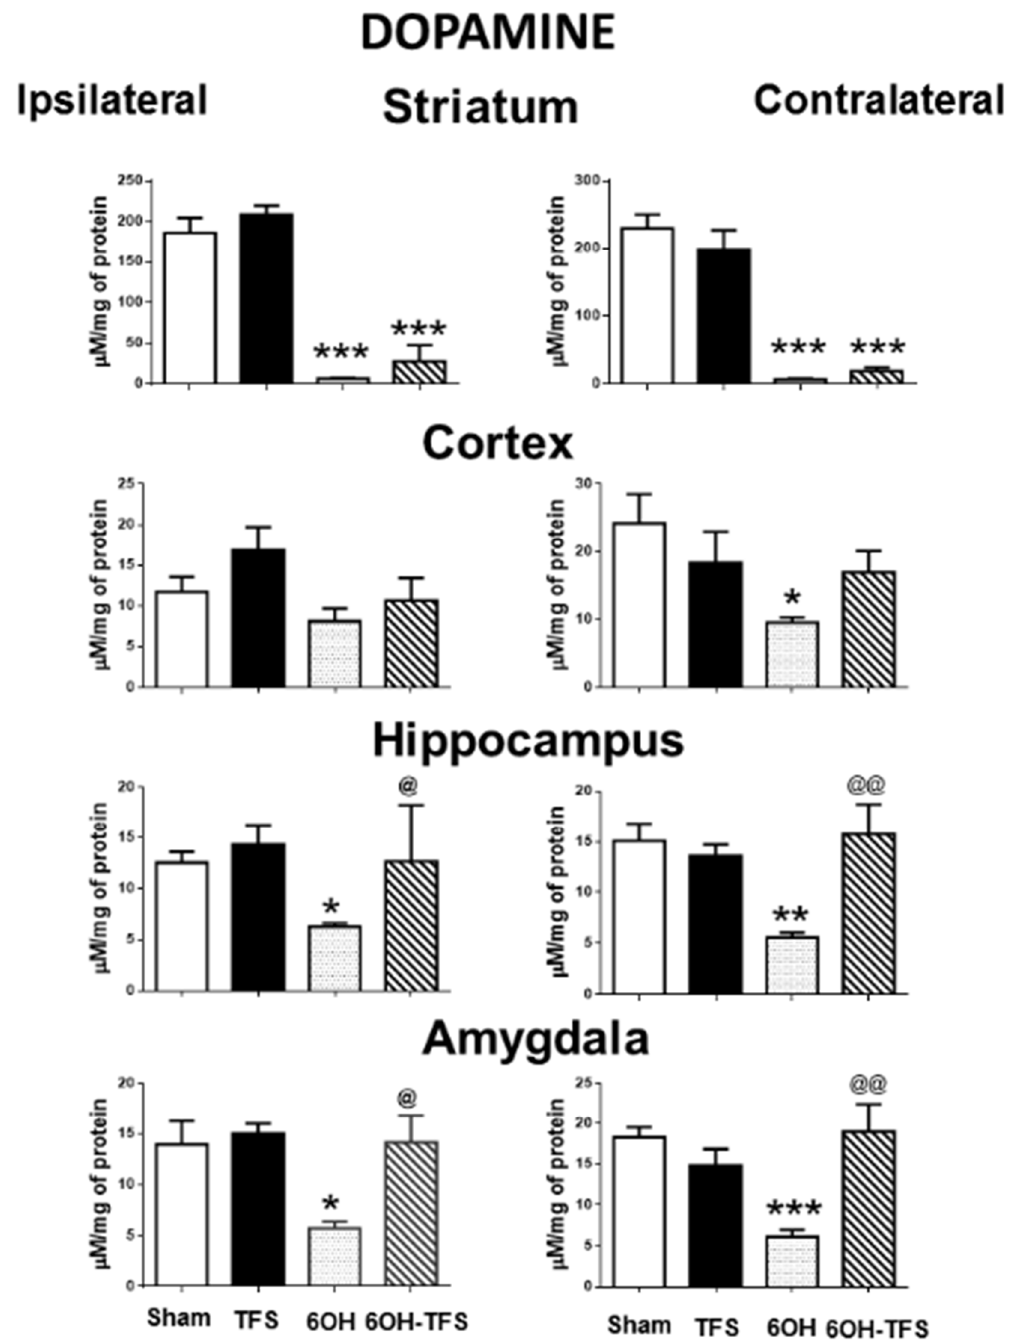
Figure 1. Effects of TFS on the changes in dopamine tissue content induced by 6-OHDA in different brain areas. Tissue content ipsi- and contralateral to the toxin injection or vehicle is expressed as µ M/mg of protein. Sham, animals with vehicle injection; TFS, animals receiving TFS daily for 21 days; 6OH, rats injected with 6-OHDA; 6-OH-TFS, animals receiving repetitive TFS after 6-OHDA injection. Data are expressed as mean ± standard error. * p < 0.05 vs Sham group; ** p < 0.01 vs Sham group; *** p < 0.001 vs Sham group; @ p < 0.05 vs 6-OHDA group; @@ p < 0.01 vs 6-OHDA group. The results obtained were analyzed with ANOVA followed by the post hoc Tukey test.